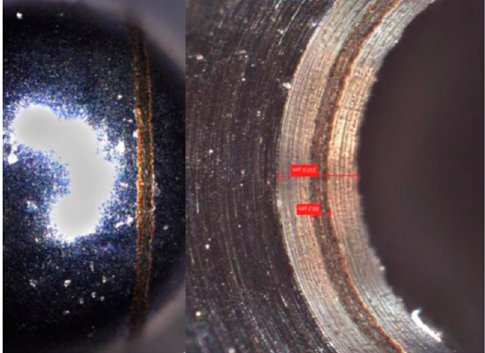
Figure 14. Damage zone (8–80 N, 500 Hz, 50 h).